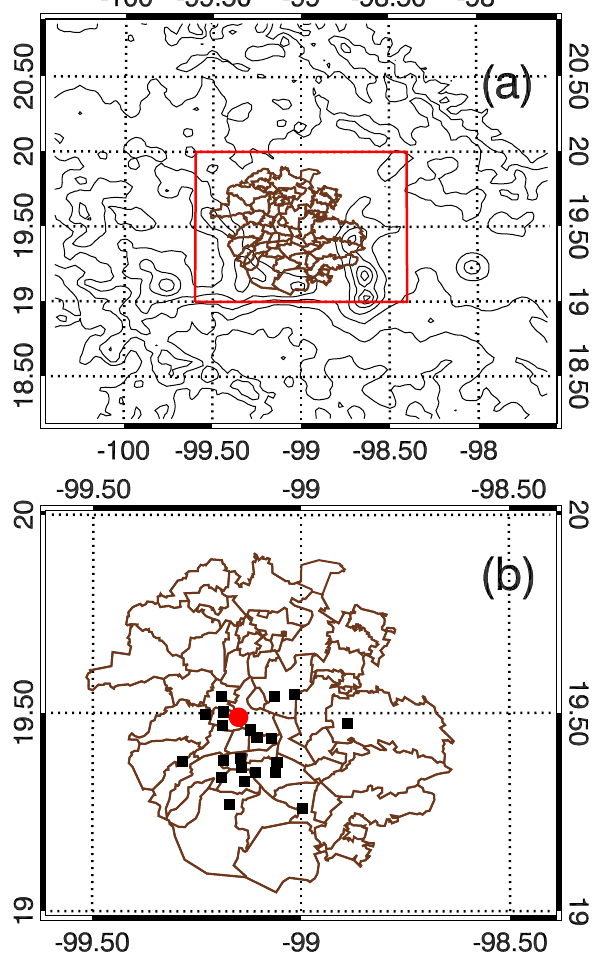
Fig. 1. WRF-CHEM simulation domain. Black squares represent the RAMA (Mexico City Ambient Air Monitoring Network) sites and red filled circle is the T0 super site at the Instituto del Petroleo (IMP) laboratories (Mexico,